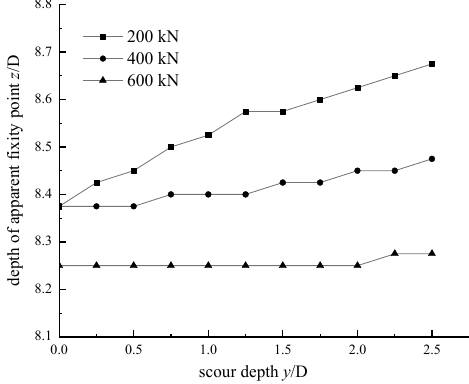
Figure 14. Pile head displacement of monopile under scour. ( a ) Scour depth–displacement under different load levels; ( b ) load–displacement under different scour depths.